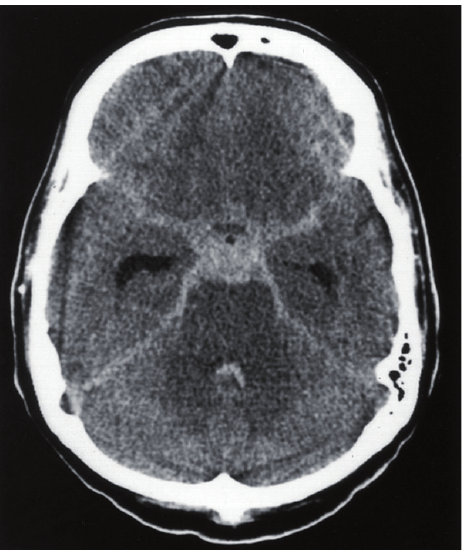
Figure 1. CT image of subarachnoid haemorrhage. Non-contrast CT scan of brain showing subarachnoid haemorrhage in classical “star sign” distribution with blood distributed along basal